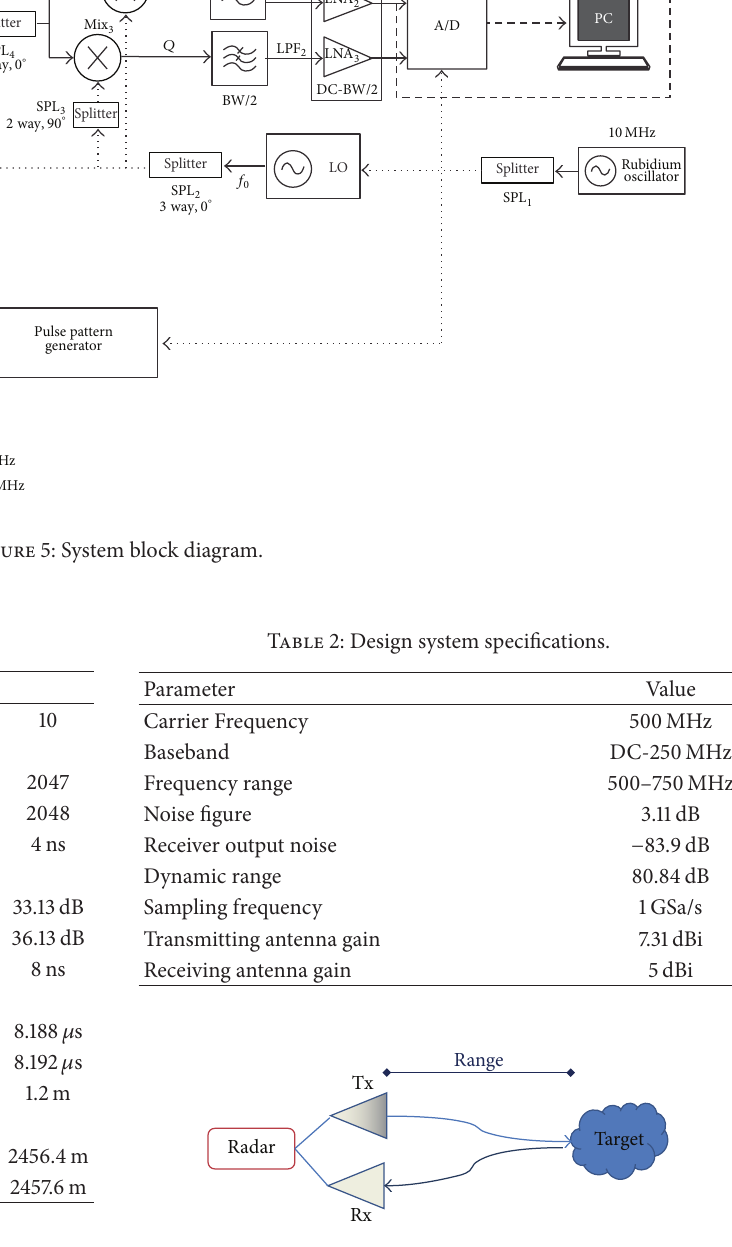
Figure 6: Bistatic radar configuration for measurement